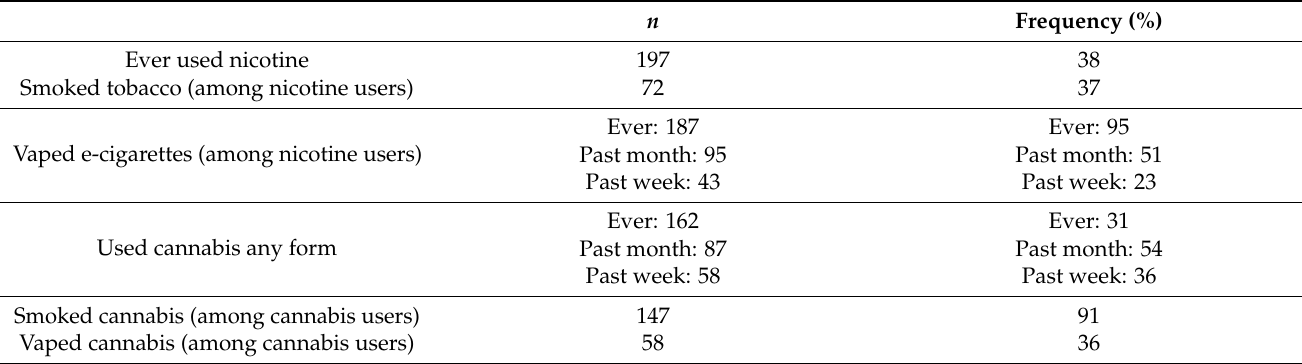
Table 2. Sample Characteristics ( n =